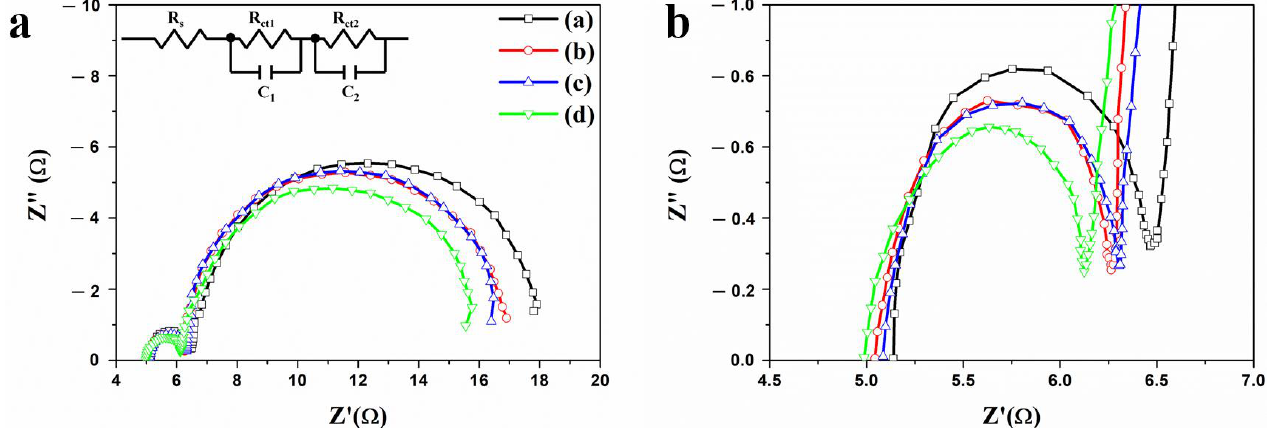
Figure 7. Impedance of DSSC based on the f-TNTAs is ( a ), and the expanded small semicircles of the impedance spectrum from ( a ) is shown in ( b ): (a) f-TNTAs without both Au NPs and a scattering layer, (b) f-TNTAs with Au NPs, (c) f-TNTAs with a scattering layer, and (d) f-TNTAs with Au NPs and a scattering layer. Table 3. Impedance properties of DSSCs based on f-TNTAs with Au NPs and a scattering layer. DSSCs Based on the